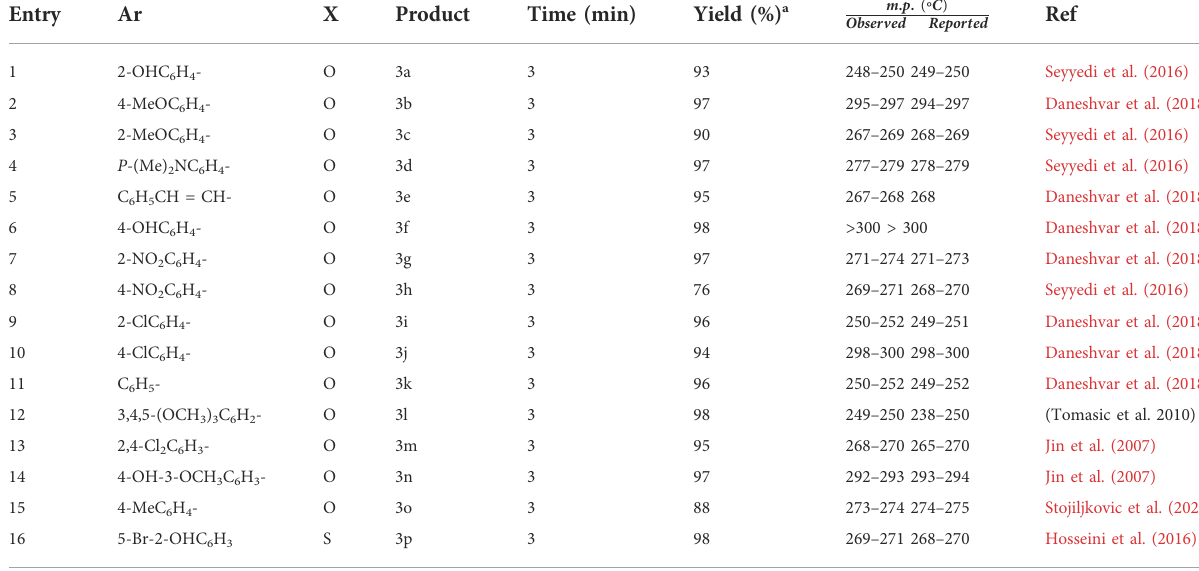
TABLE 2 Benzylidene barbituric acid derivatives obtained via the Knoevenagel condensation of benzaldehyde derivatives and barbituric acid using Bi 2 O 3